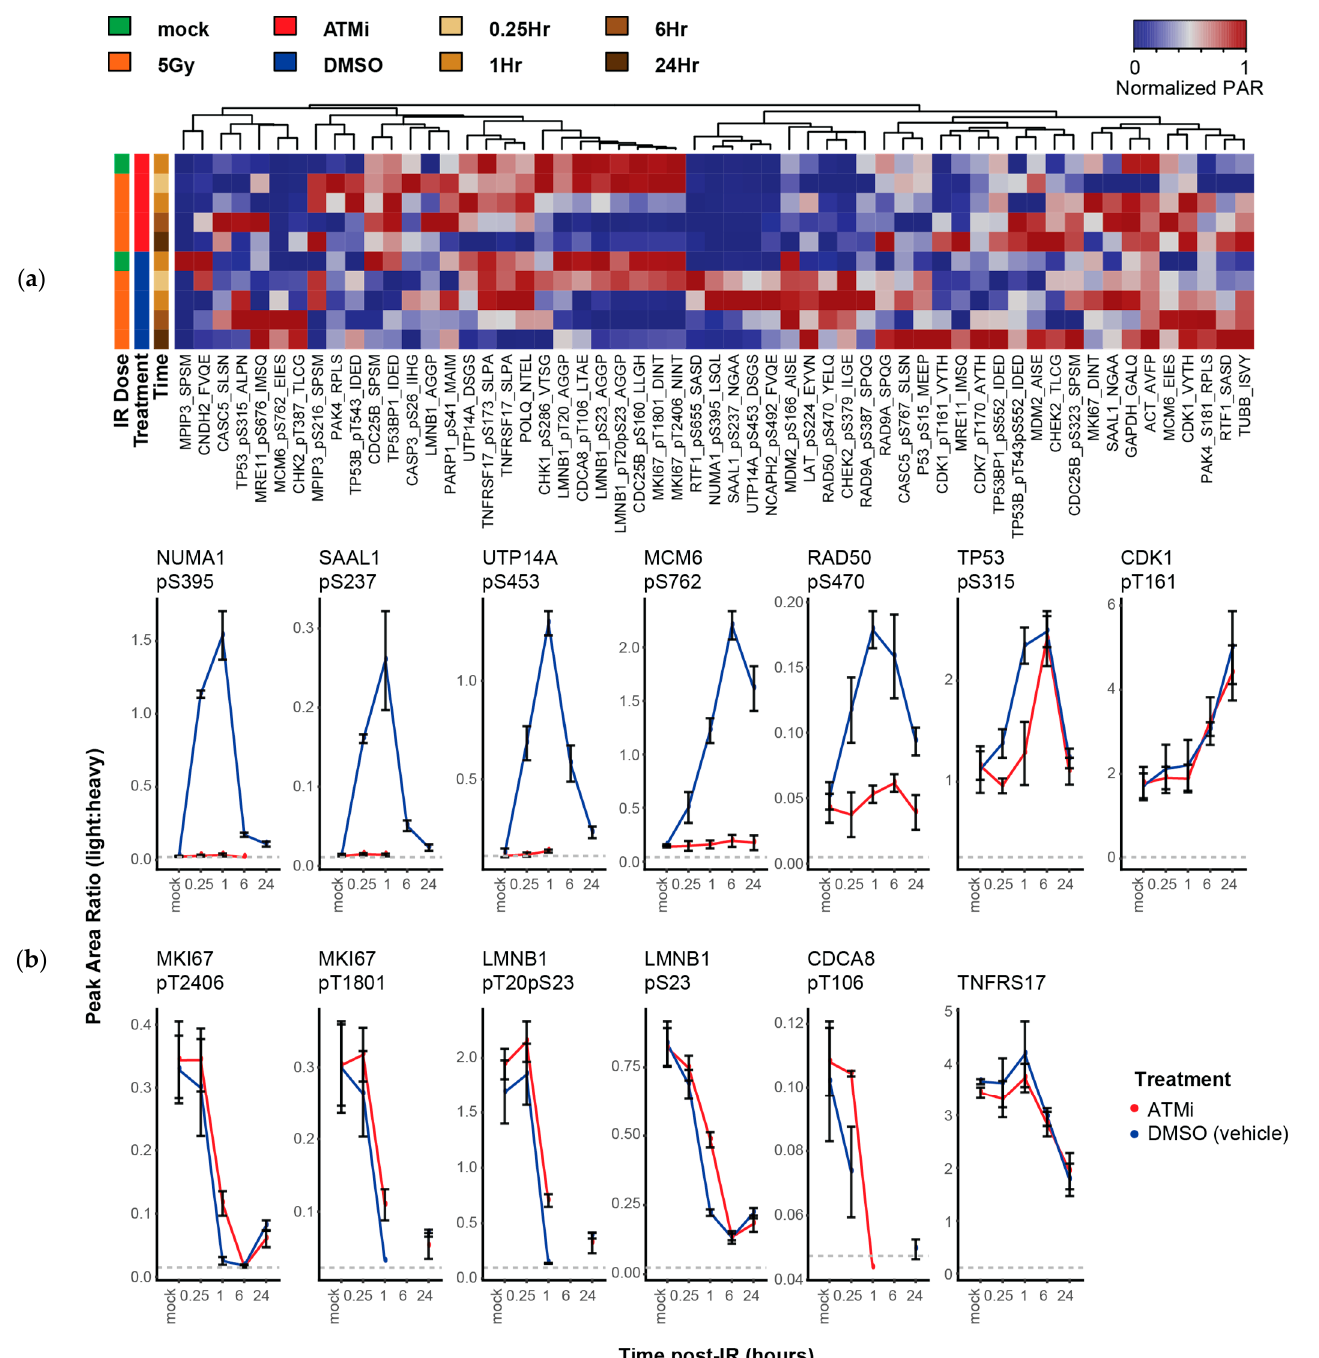
Figure 3. The DDR-2 immuno-MRM assay detects changes in phosphorylation dynamics due to ATM kinase inhibition. ( a ) Heatmap showing unsupervised clustering of analytes in LCL-57 exposed to ionizing radiation in the presence of ATM inhibitor (or control vehicle, DMSO). Peak area ratios (light:heavy) were normalized for each peptide analyte. ( b ) Bar plots showing peak area ratios (light:heavy) of analytes with greater than 2-fold change quantified by immuno-MRM. Blue lines show control (DMSO vehicle) and red lines show samples treated in the presence of ATM inhibitor. Error bars the standard deviation of biological triplicate analysis.